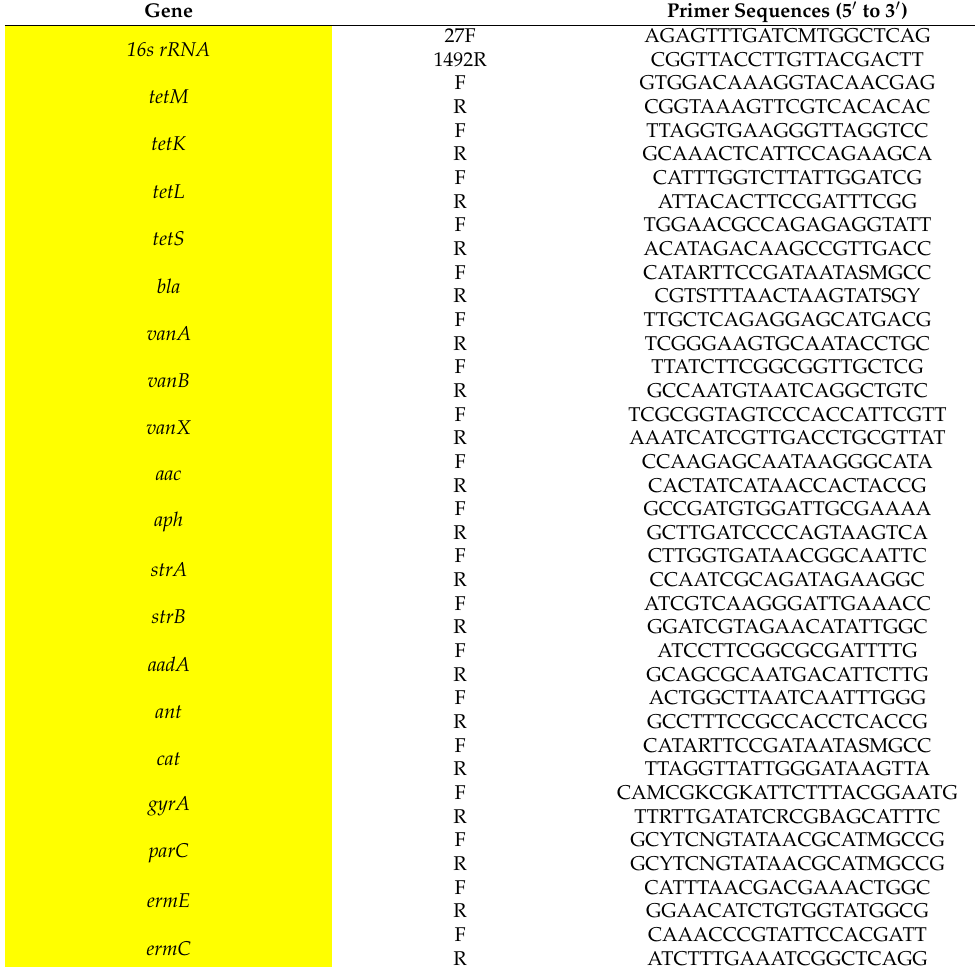
Table 1. List of primers used to detect the virulence genes. Gene Primer Sequences (5 (cid:48) to 3 (cid:48)